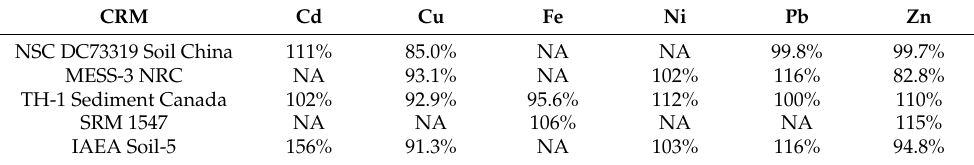
Table 2. Heavy metals analysis recovery percentages of the certified reference materials